Question: Reading the figure, is the described quantity rising or falling?
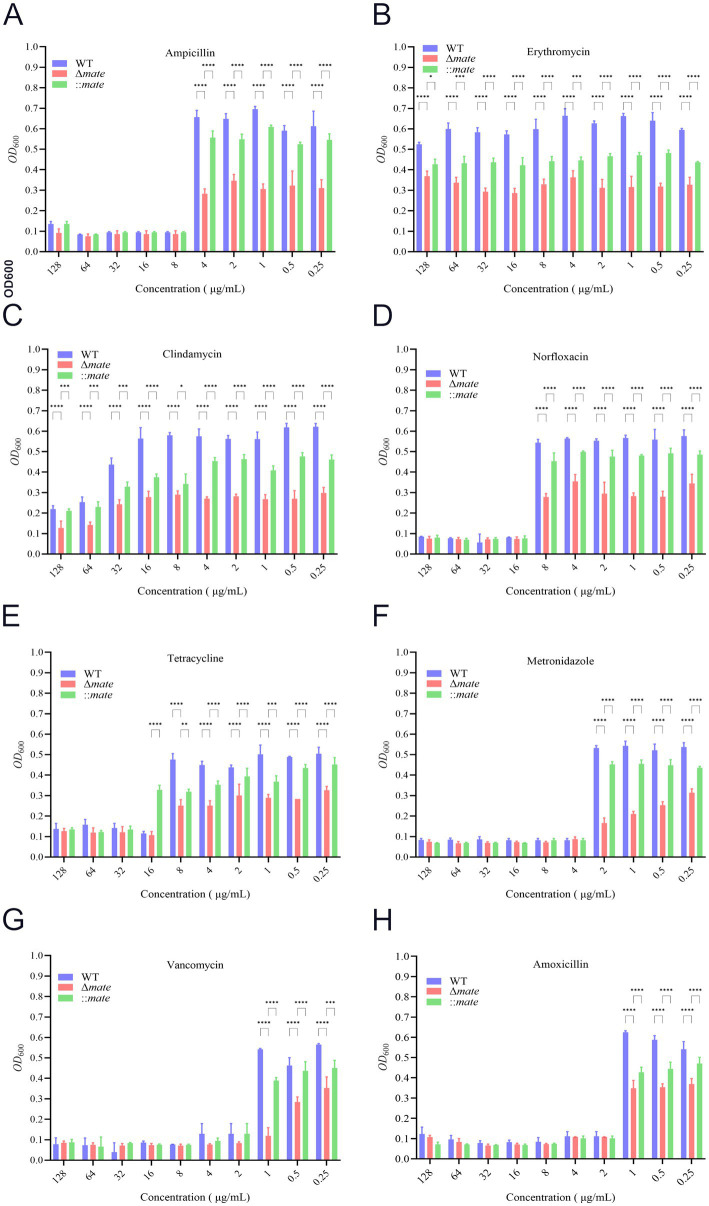
Answer: decreasing